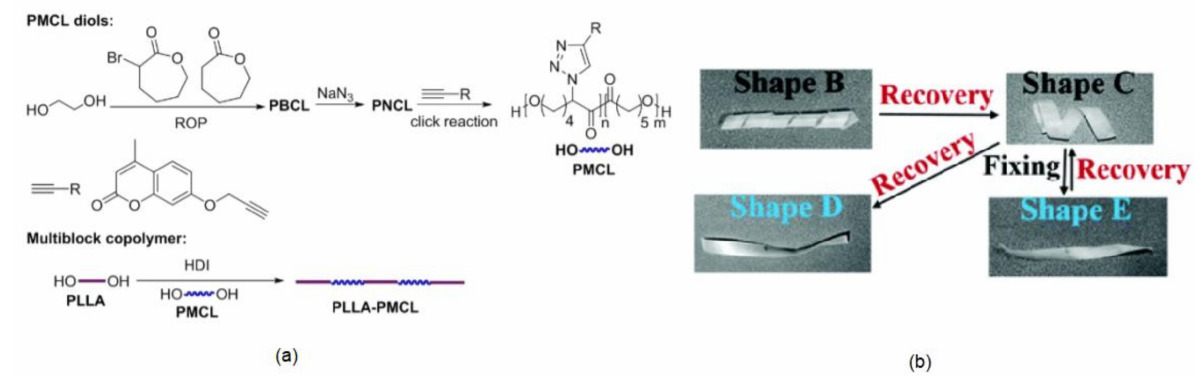
Figure 40. ( a ) Synthetic route of multiblock polymers PLLA-PMCL1. ( b ) Visual demonstration of the triple-shape-memory performance of PLLA-PMCL. Republished with permission of the Royal Society of Chemistry, from [201]; permission conveyed through Copyright Clearance Centre, Inc.